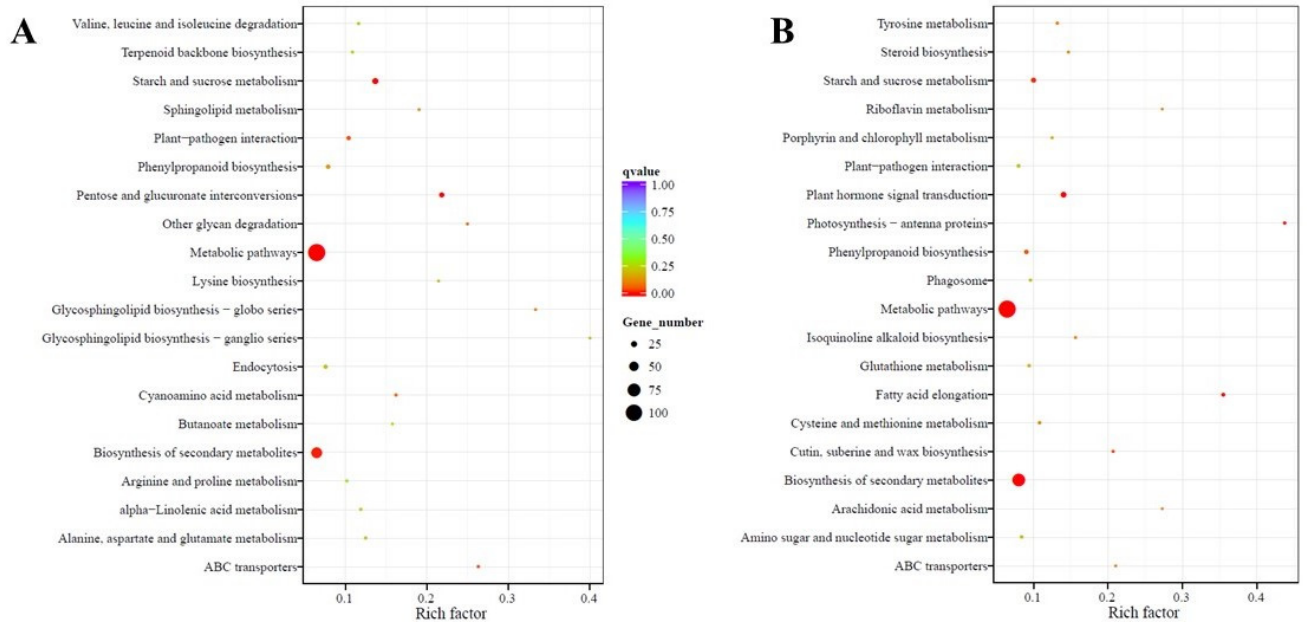
Figure 5. Statistics of pathway enrichment: The KEGG enrichment scatter plot analysis shows enriched pathways for ( A ) up and ( B ) downregulated differentially expressed genes (DEGs) in leaf tissue of PI 175311. The Rich factor is the ratio of DEGs in this pathway term to all gene numbers annotated in this pathway term. A q-value is the corrected p -value ranging from 0 to 1, and a lower value indicates greater pathway enrichment. The pathway names are shown on the y-axis, rich factor on the x-axis, size of the point represents the number of DEGs, and the color of the dot represents the q-value.